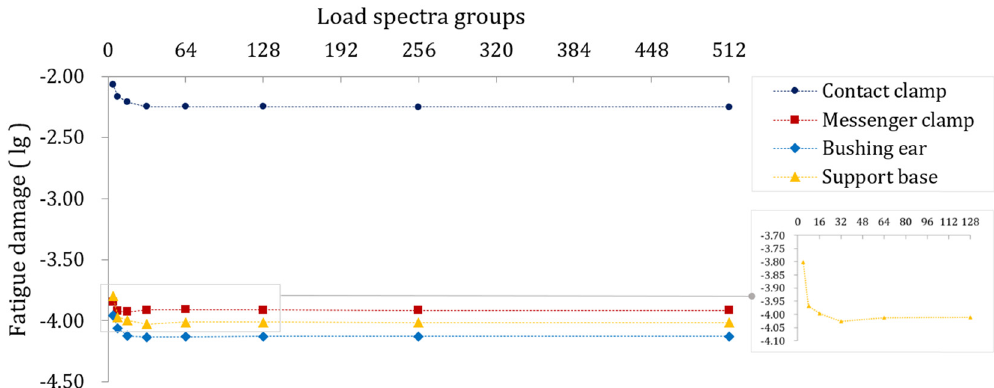
Figure 20: Fatigue damage convergence with load spectra group number.